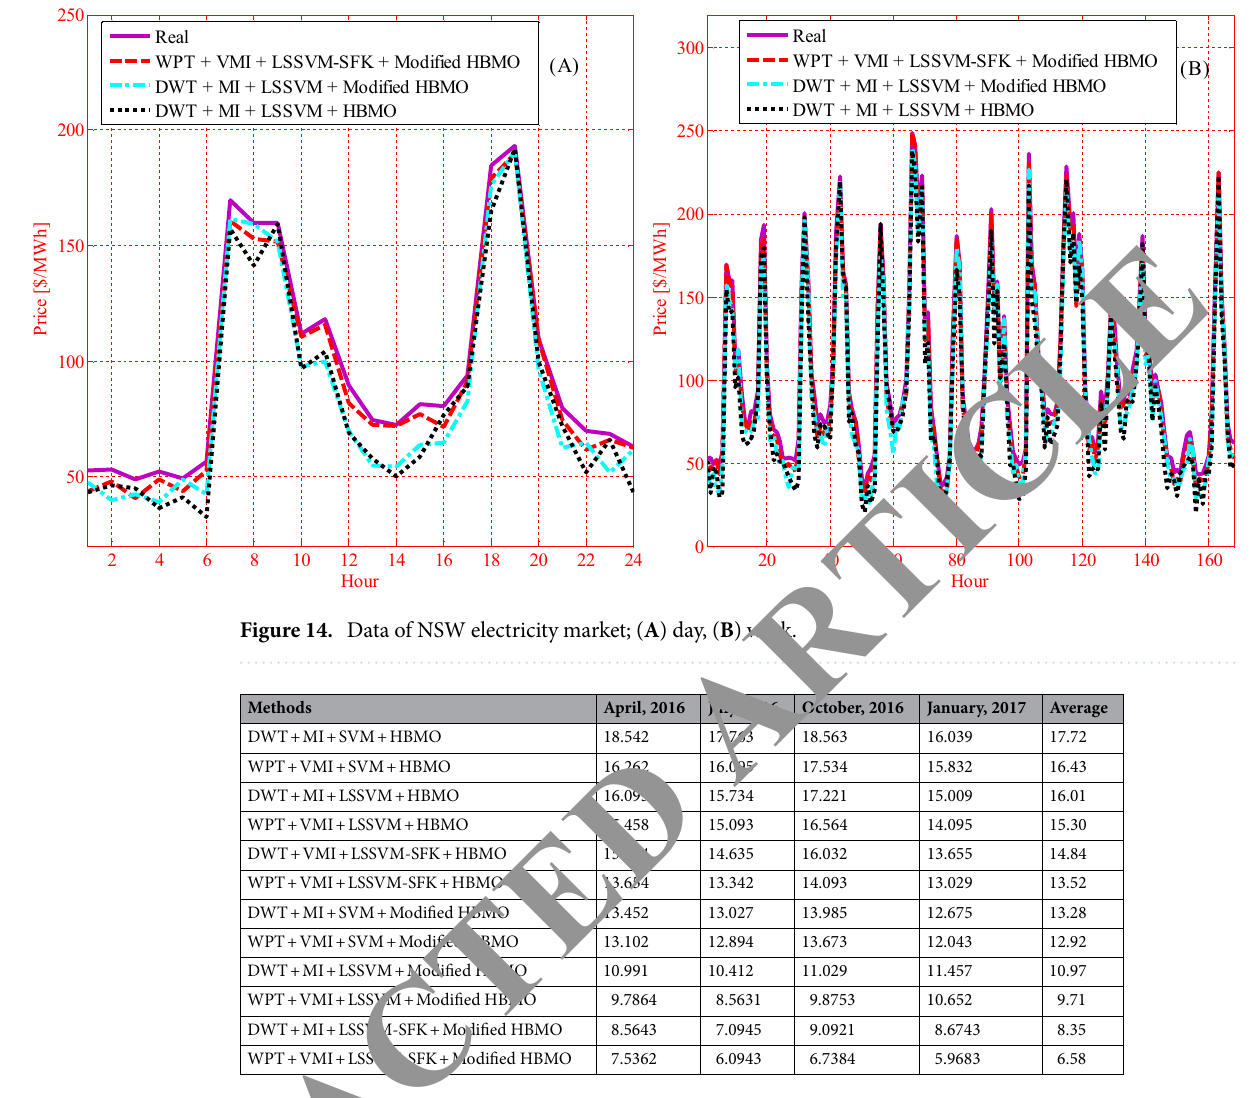
Table 5. MAPE of forecasting error of electricity market.